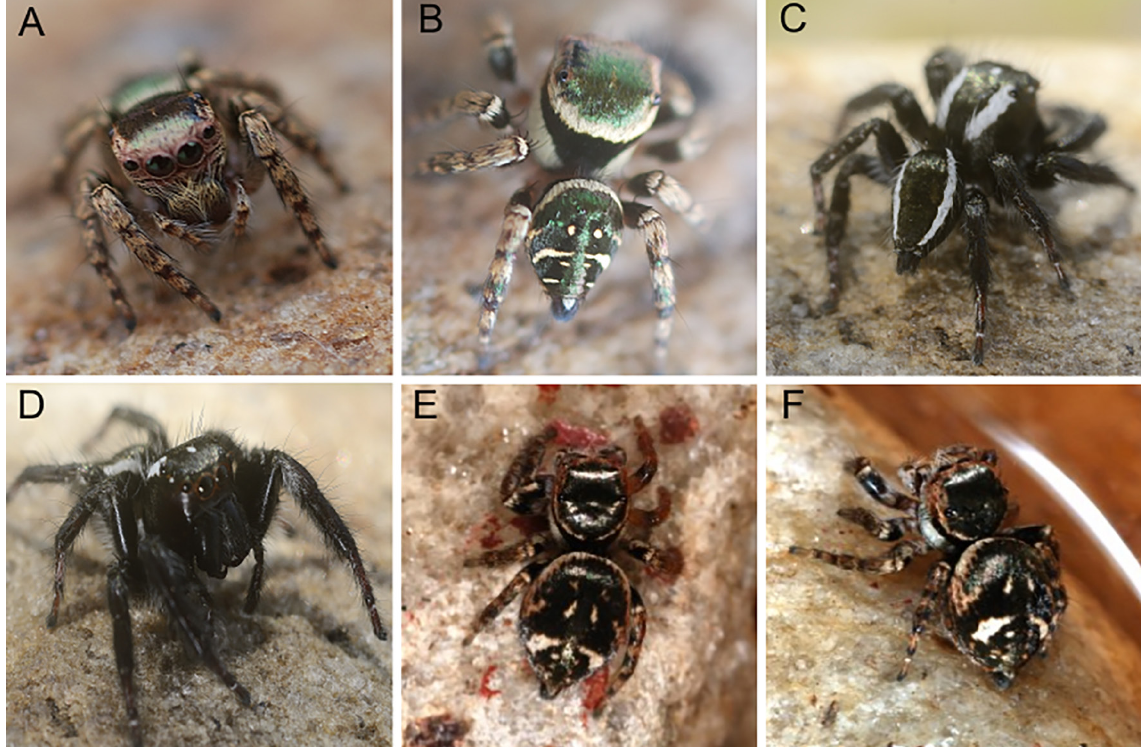
Fig 2. Photographs of live Carrhotus spp. A–B . Carrhotus albosetosus sp. nov ., female from Pillikutuwa. C–D . C. viduus , male from Mandaitivu . E–F . C. taprobanicus , female from